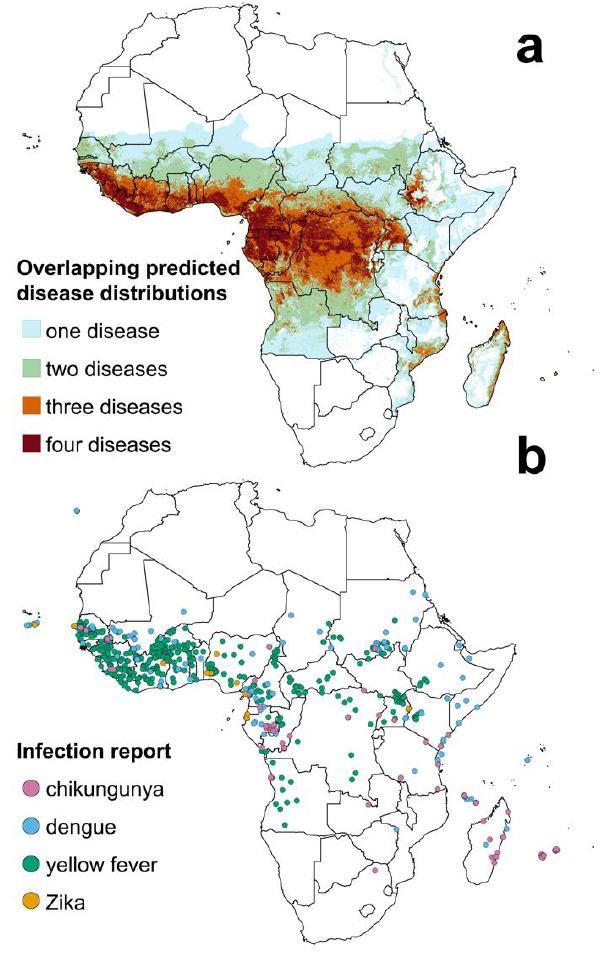
Figure 1. The distributions of chikungunya, dengue, yellow fever and Zika virus infections in humans in Africa. ( a ) Areas at risk of one, two, three or all four infections; map generated as described in Supplementary Methods. ( b ) Locations of reported infections (symptomatic and non-symptomatic) of dengue, chikungunya, Zika and yellow fever [24 – 28].